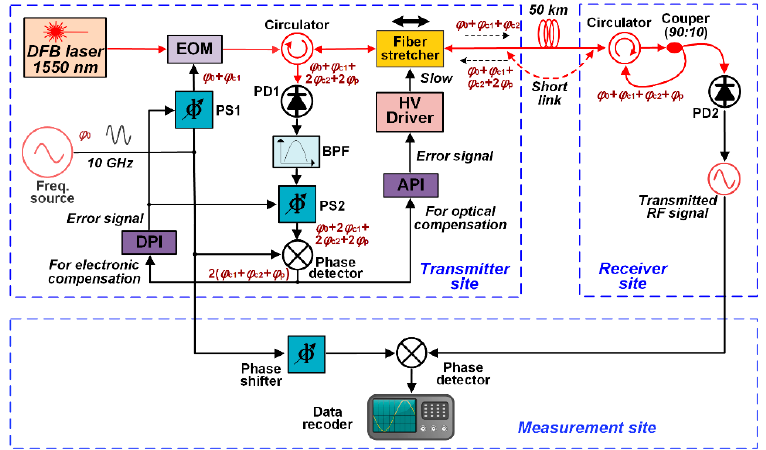
Figure 3. Schematic of fiber-based RF transfer with optical–electronic joint phase compensation. CW: continuous wave, EOM: electro-optical modulator, PS: phase shifter, BPF: band-pass filter, HV: high voltage, PD: photodiode, API: analog proportional-integral controller. DPI: digital proportional- integral